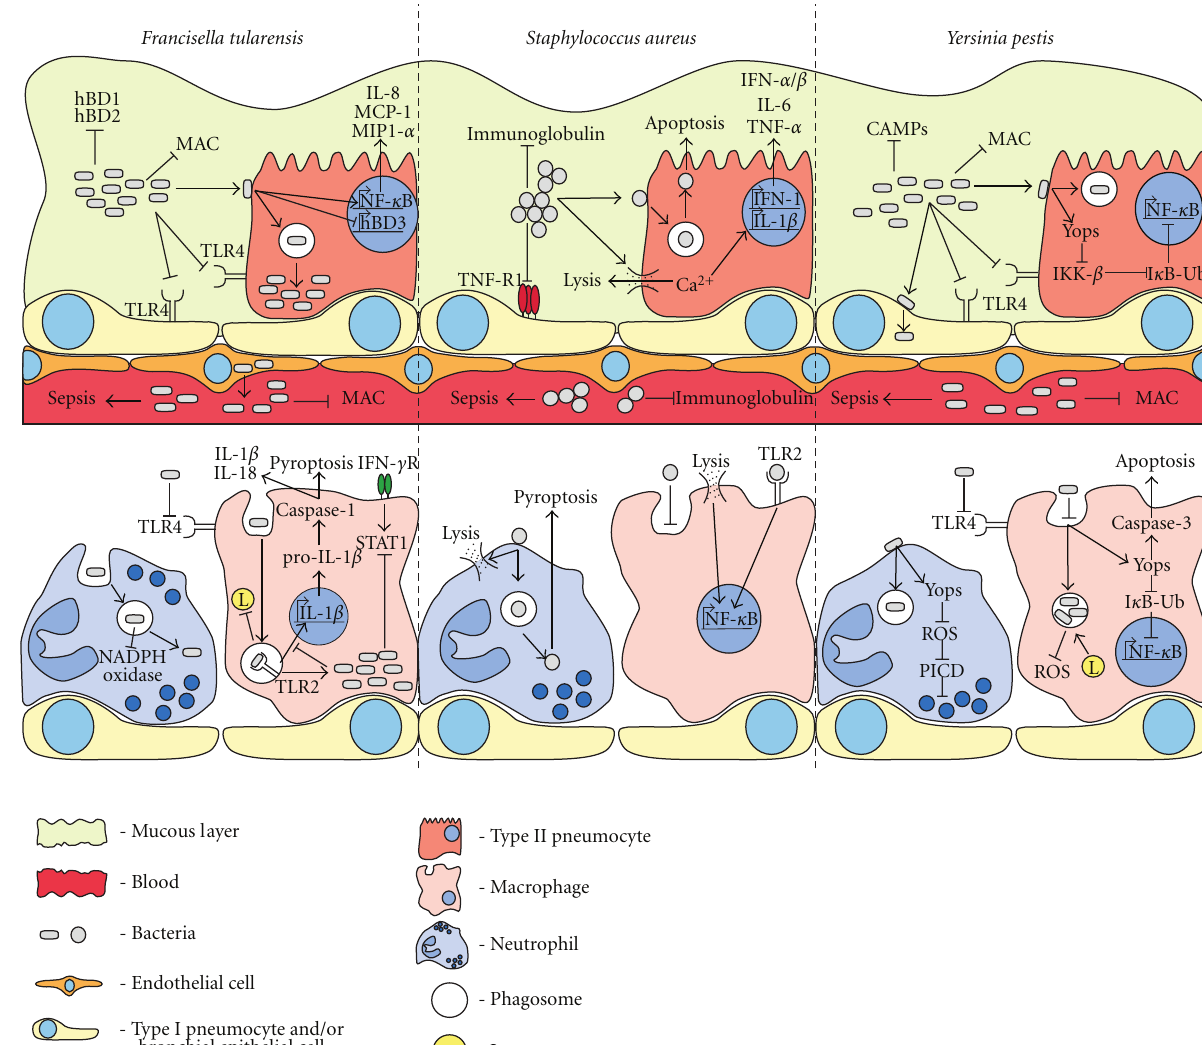
Figure 1: Disruption of airway defenses by Francisella , Staphylococcus, and Yersinia . Summary of host pathogen interactions used by these bacteria to modulate innate immune responses and invade the